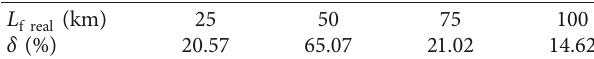
Table 1: Fault location error in cases of different distances to the fault and application of the real electromagnetic current